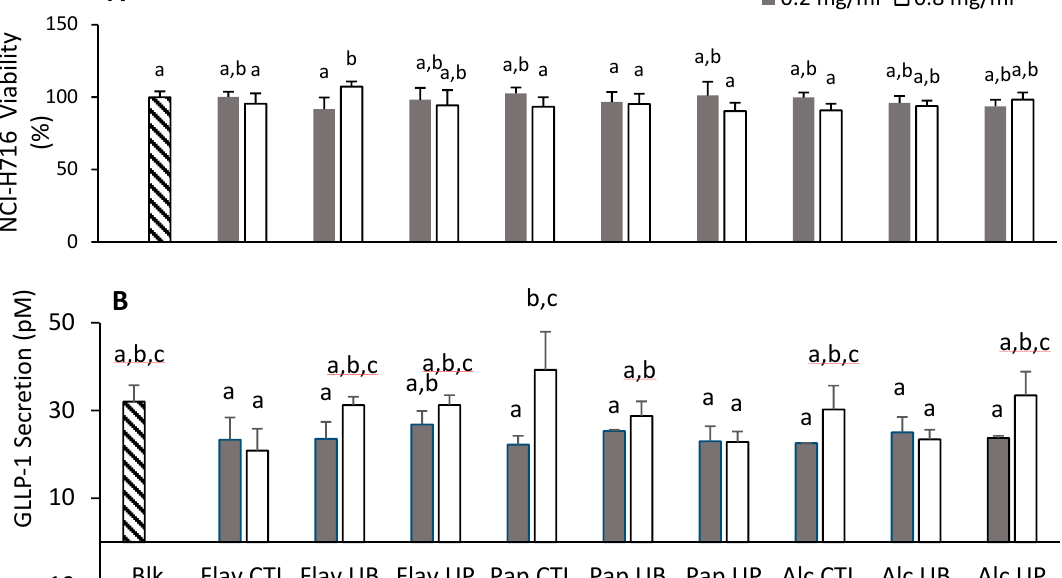
Figure 5. ( A ) Cell viability of NCI-H716 cells as determined by an 3-(4,5-dimethylthiazol-2-yl)-2,5-diphenyltetrazolium bromide (MTT) assay; ( B ) GLP-1 secretion stimulated by hydrolysates. Cells were plated at 5 × 10 4 cells in a 96-well microplate with Matrigel for 24 h and were treated with hydrolysate for 2 h. Data are expressed as the mean of triplicates ± the standard deviation. The letters above each bar represent significant differences, as determined with an LSD test in a one-way ANOVA ( p -value < 0.05).